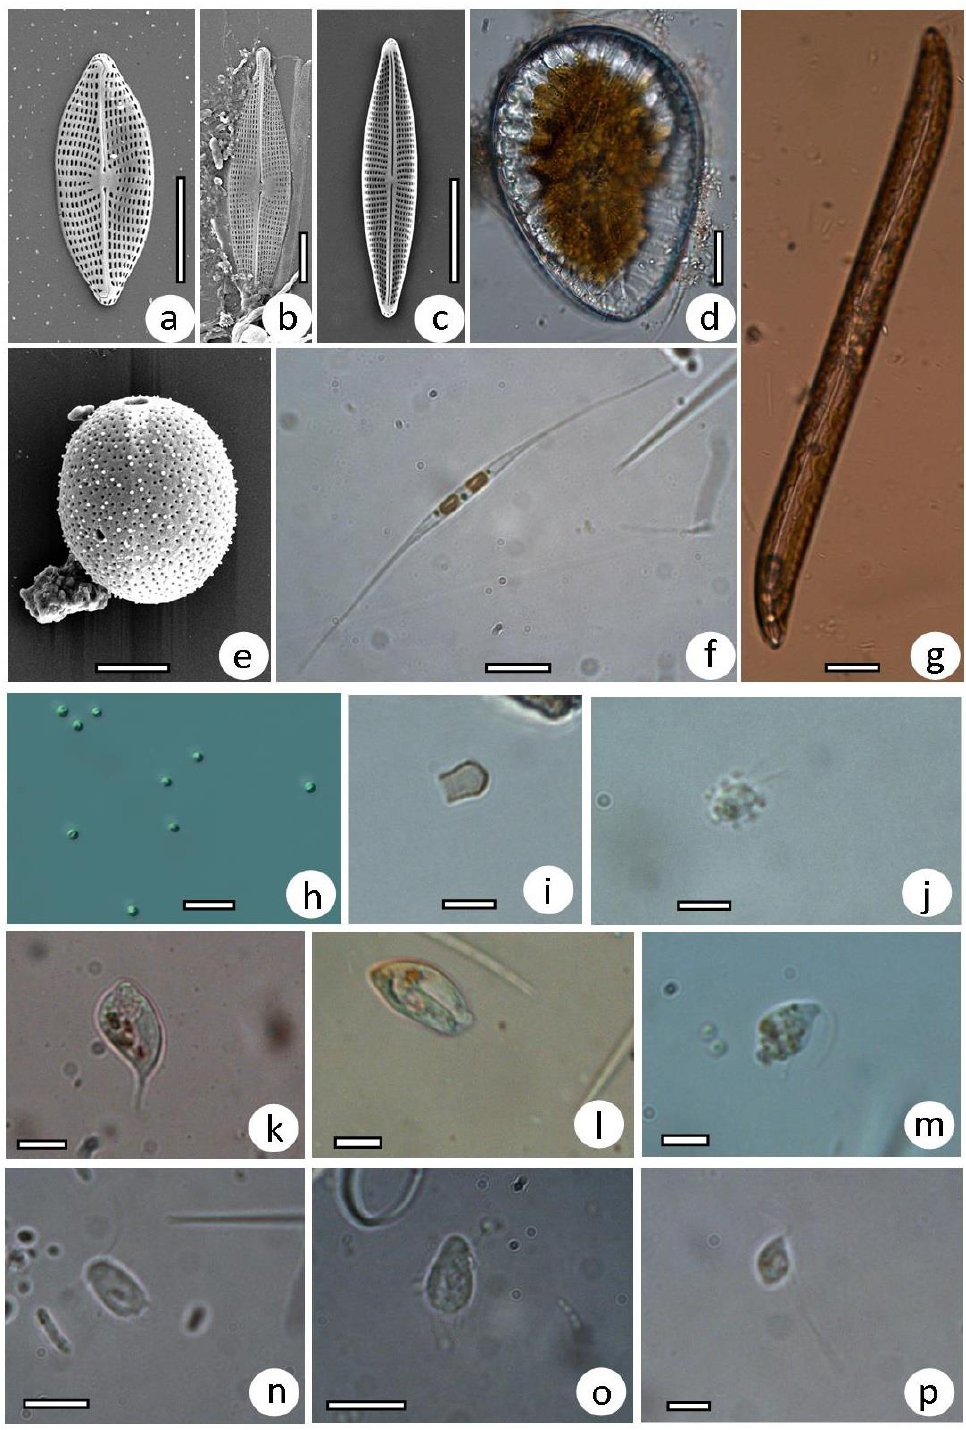
Figure 9. Morphology of protists observed (LM — d , f – p SEM — a – c , e ): ( a ) Navicula antonii ; ( b ) Na- vicula gregaria ; ( c ) Navicula sp.; ( d ) Surirella striatula ; ( e ) Trachelomonas intermedia var. minor ; ( f ) Cyl- indrotheca closterium ; ( g ) Gyrosigma sp; ( h ) unidentified Chlorophyta 2; ( i ) Kephyrion sp.; ( j ) uniden- tified Haptophyta; ( k ) unidentified Symbiontida; ( l ) unidentified Euglenozoa; ( m ) unidentified flagellate; ( n , o ) Hexamita sp.; ( p ) Carpediemonas membranifera . Scale bars: 5 µm — a – c , e , h , i , j , m , p ; 10 µm — f , k , l , n , o ; 20 µm — d , g . A bloom of Cryptophyta represented by Rhodomonas cf. baltica was detected in the chemocline at 3.0 – 3.1 m, but it was also found at 2.5 m. The specific protist community of